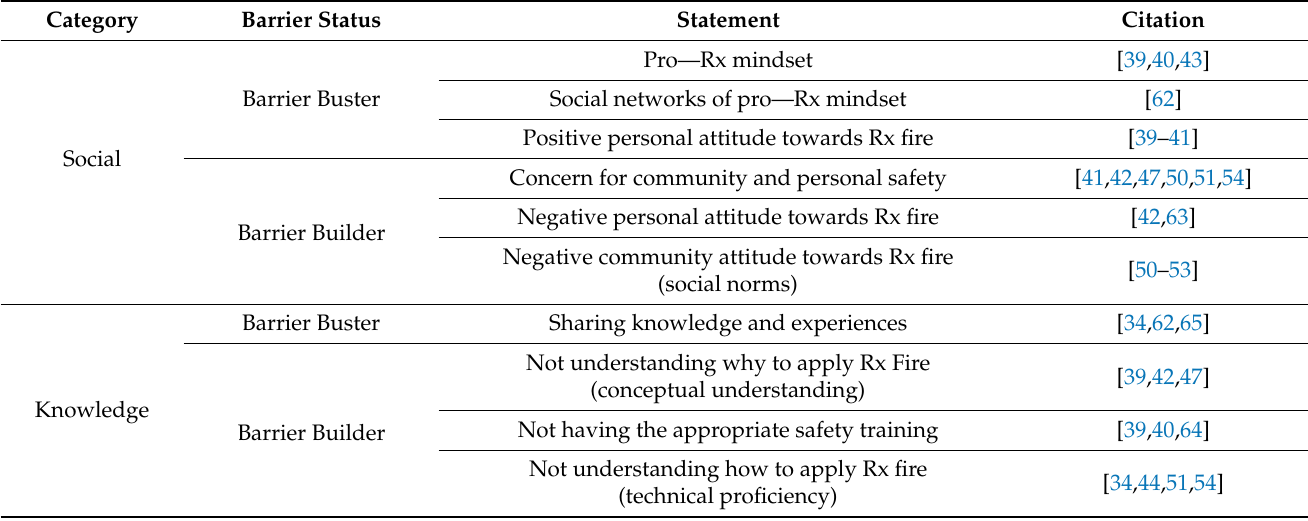
Table A1. Figure 3 presented in tabular format, with APA citations for each text box in the